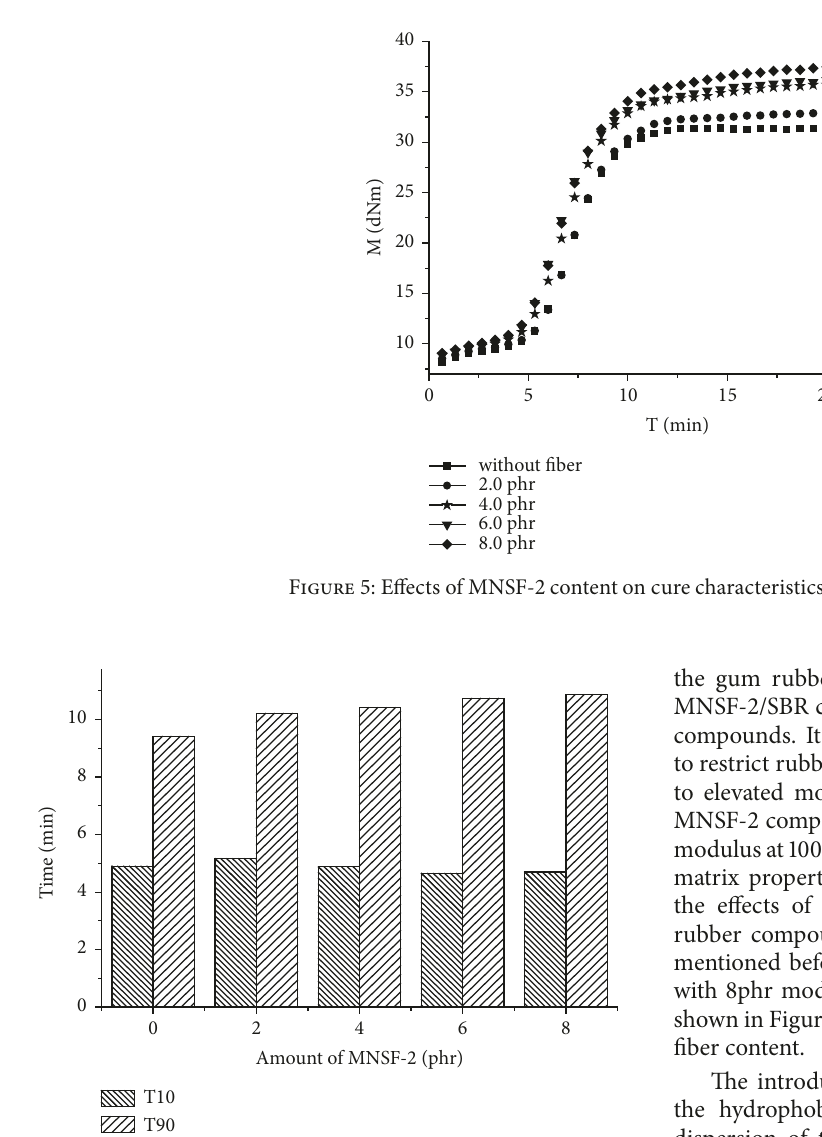
Figure 6: Effects of MNSF-2 content on t 10 and t 90 of tread